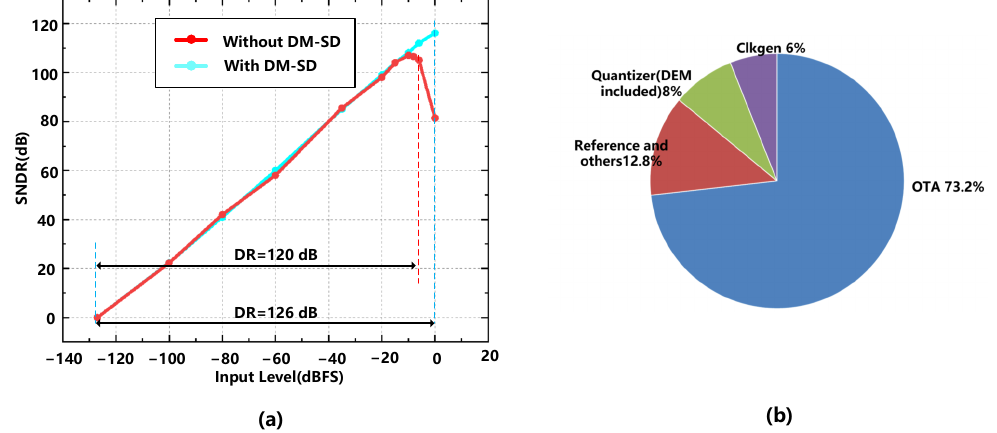
Figure 19. ( a ) SNDR versus input amplitude with/without DM-SD. ( b ) Total power consumption breakdown among circuit